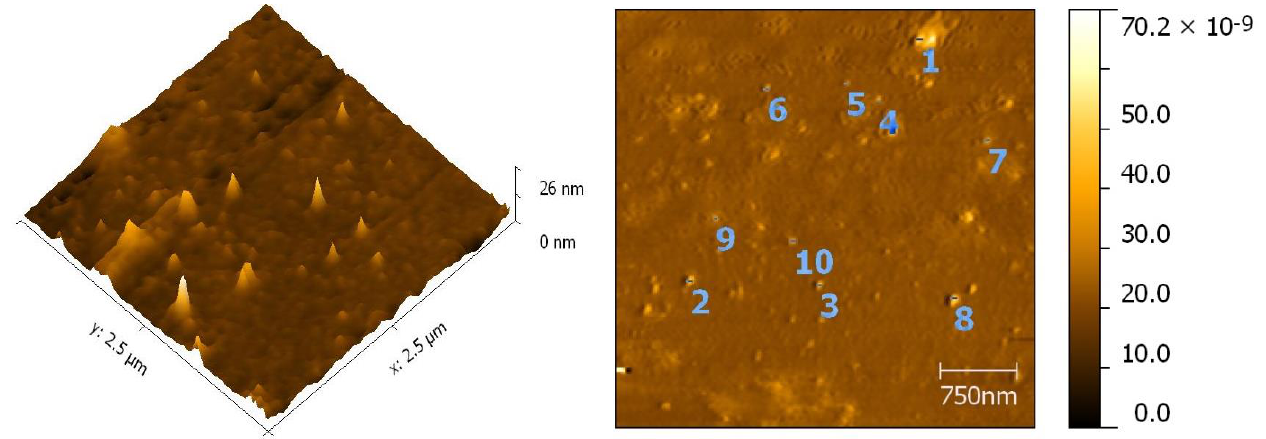
Figure 9. Atomic force micrograph showing the two-dimensional image of the synthesized AgNPs with an average size of 50 nm.